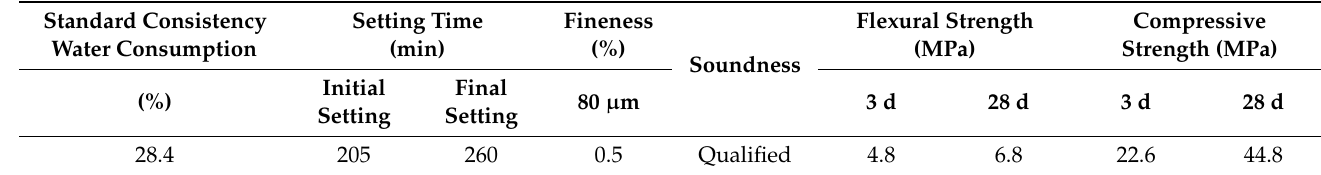
Table 1. Physical properties of the cement.